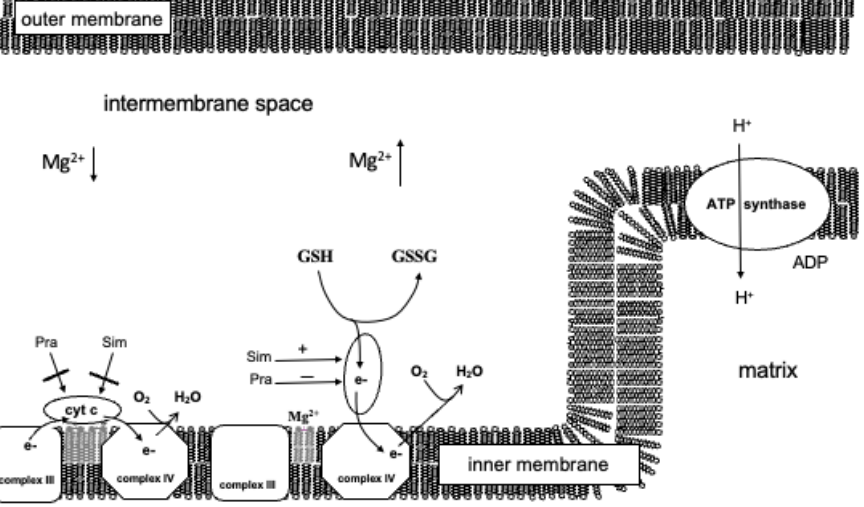
Figure 5. The assumed direct effect of pravastatin and simvastatin on the